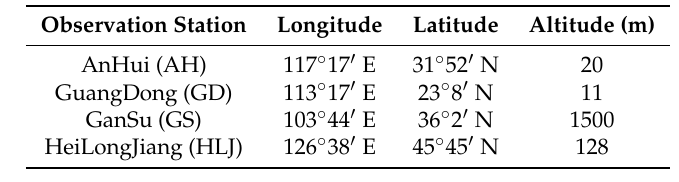
Table 1. Locations of four observation stations in China.